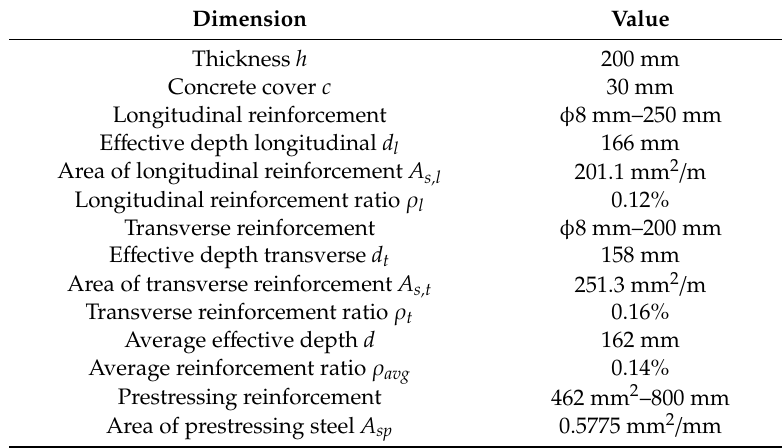
Figure 1. Van Brienenoord Bridge: ( a ) sketch of the elevation of the entire bridge structure, showing the approach slabs, as well as the steel arch; ( b ) cross-section of the slab-between-girder approach bridge. Dimensions in cm. Table 1. Main properties of geometry and reinforcement of the decks of the Van Brienenoord